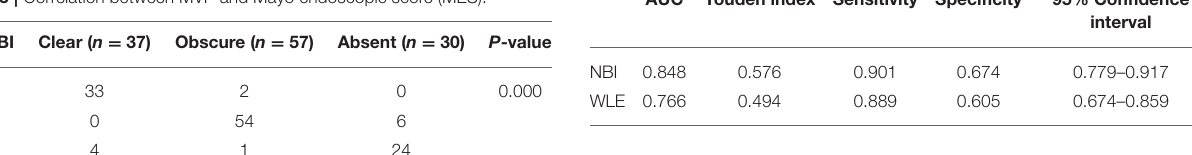
TABLE 3 | Correlation between MVP and Mayo endoscopic score (MES).